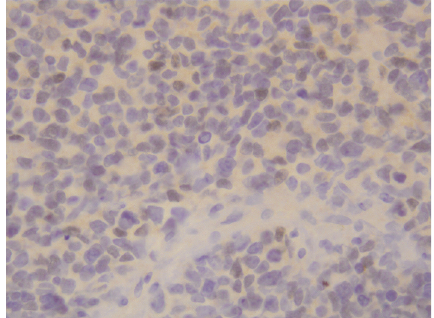
Figure 6: Tumor cells grow in nests separated by hyalinized fibrous septa (X200, H&E stain).